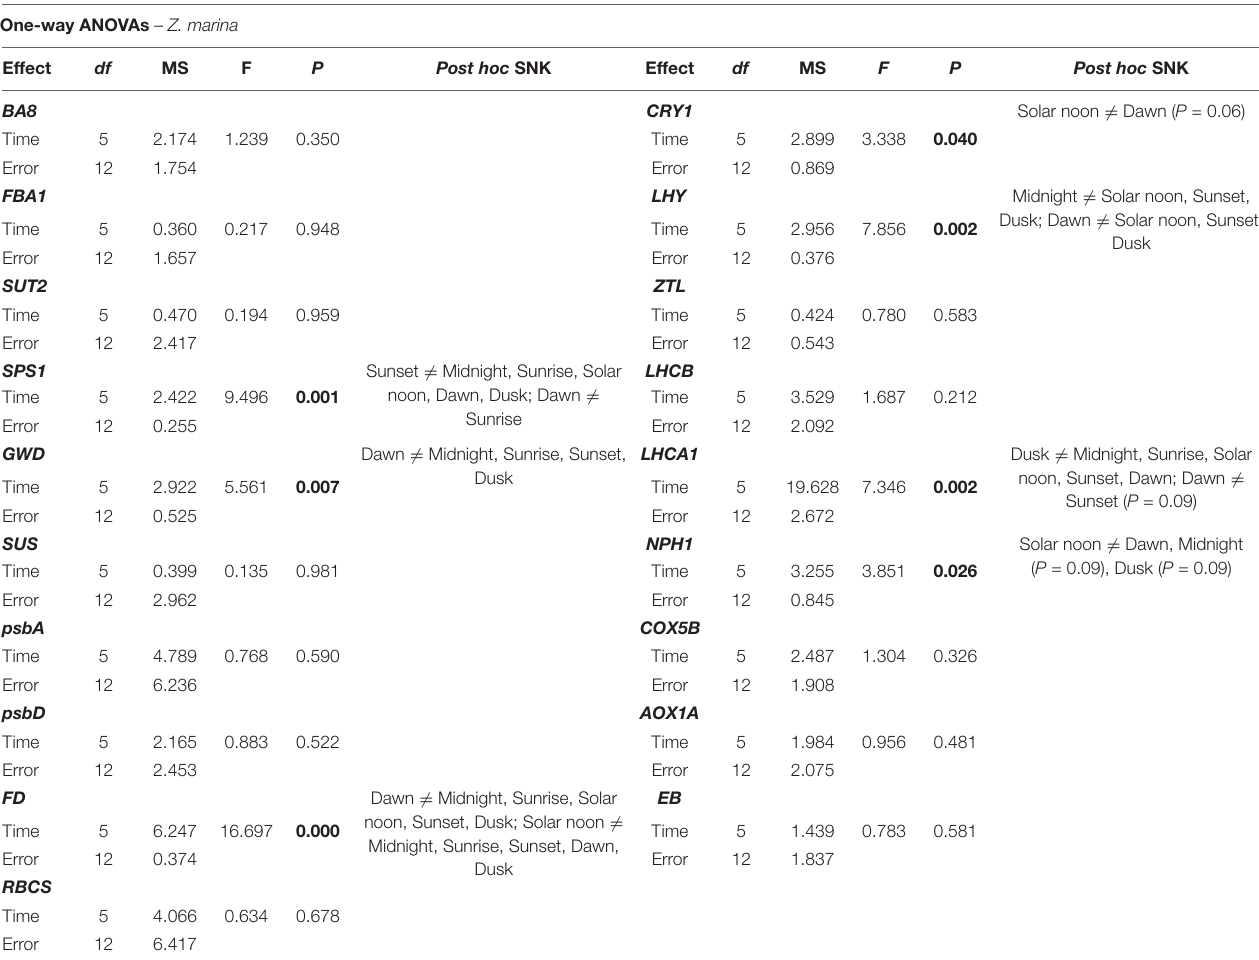
TABLE 4 | Results of one-way ANOVAs based on – (cid:49) CT data of individual Genes of Interests in Zostera marina . One-way ANOVAs – Z.